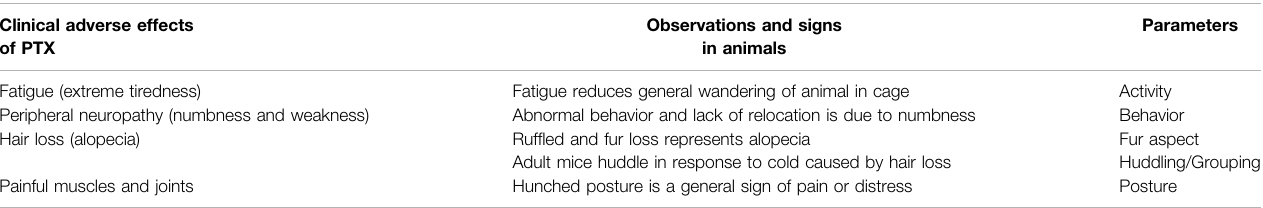
TABLE 1 | Rationale of morbidity analysis.